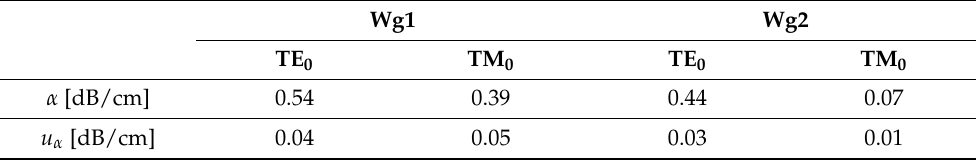
Table 4. Measured values of optical transmission losses in Wg1 and Wg2